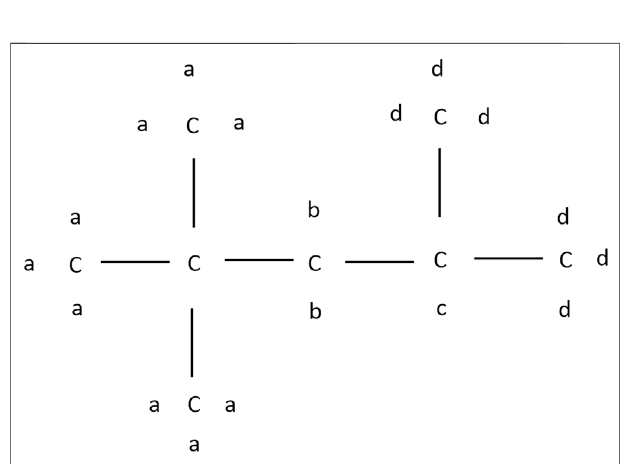
FIGURE 6 | Molecular structure of